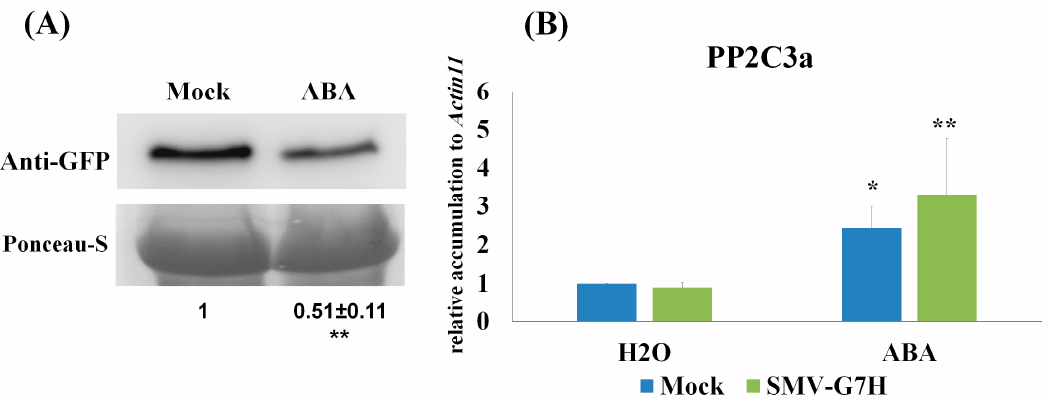
Figure 4. Effect of exogenous application of ABA on the SMV-G7H-GFP and PP2C3a levels in L29 soybean cultivar. ( A ) Protein blot for SMV-G7H-GFP in response to exogenous application of ABA (100 µ M) or Mock (0.1% MeOH). Upper panel is GFP level, and lower panel is ponceau-S as loading control. ( B ) RTqPCR of PP2C3a gene in response to SMV-G7H-GFP infection, ABA, or a mix of both. Actin11 was used as internal control. Data are means ± standard deviation from 3 biological replicates.